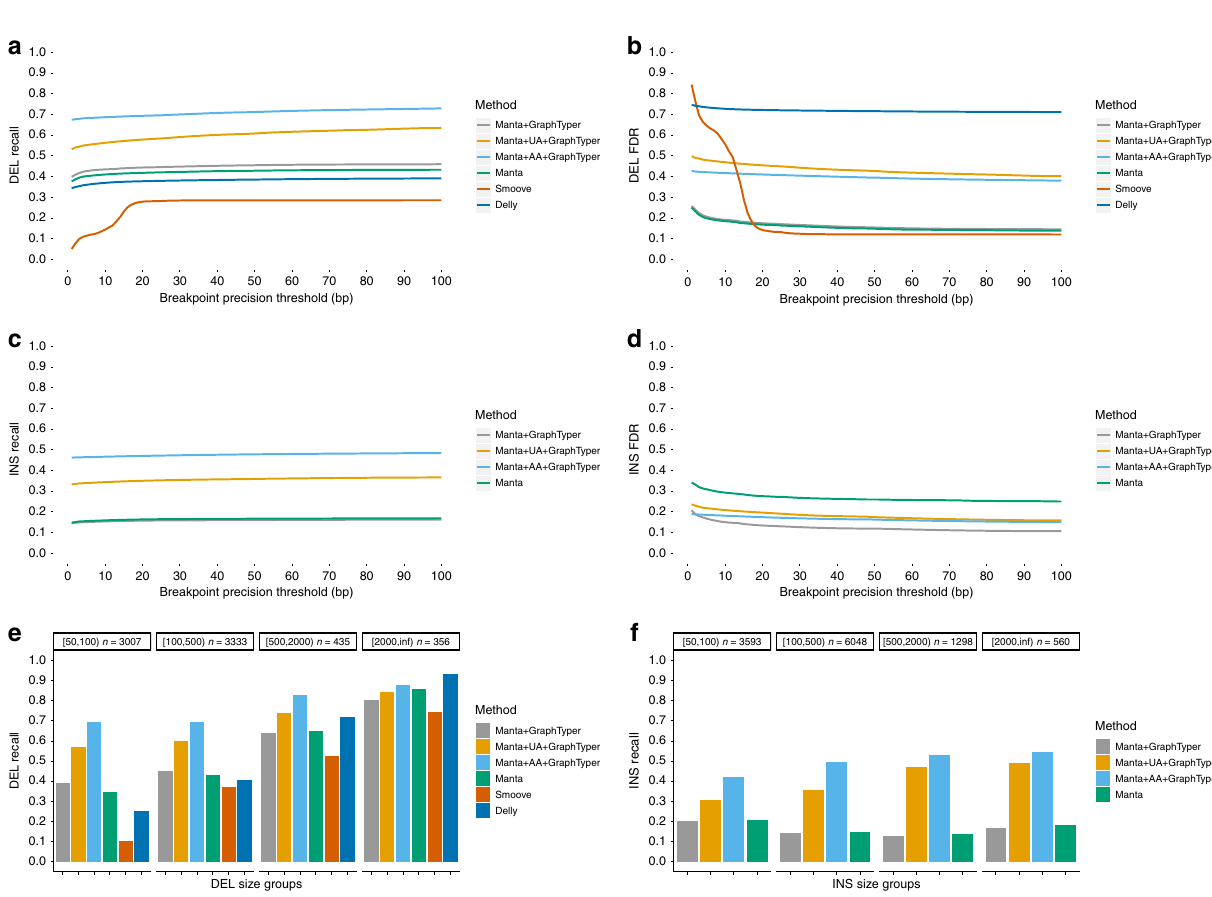
Fig. 2 Comparisons to SVs in the syndip dataset. The breakpoint precision threshold is the maximum number of base-pairs we allowed at both breakpoints for an SV to be considered recalled. a Deletion recall comparison between SV genotyping methods. b Deletion false discovery rate comparison. The Manta and Manta + GraphTyper lines are overlapping. c Insertion recall comparison. Delly and smoove were not evaluated since they are not designed to discover all types of insertions. The Manta and Manta + GraphTyper lines are overlapping. d Insertion false discover rate comparison. e Deletion recall by deletion size with a breakpoint precision threshold of 50 bp. f Insertion recall by insertion size with a breakpoint precision threshold of 50